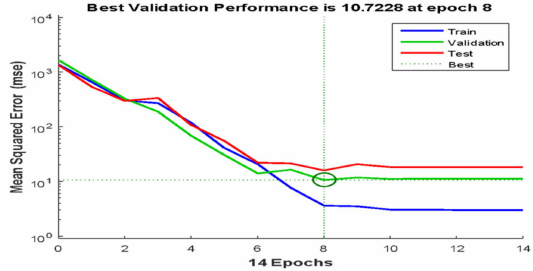
Figure 16. Network training cycles in site 2.